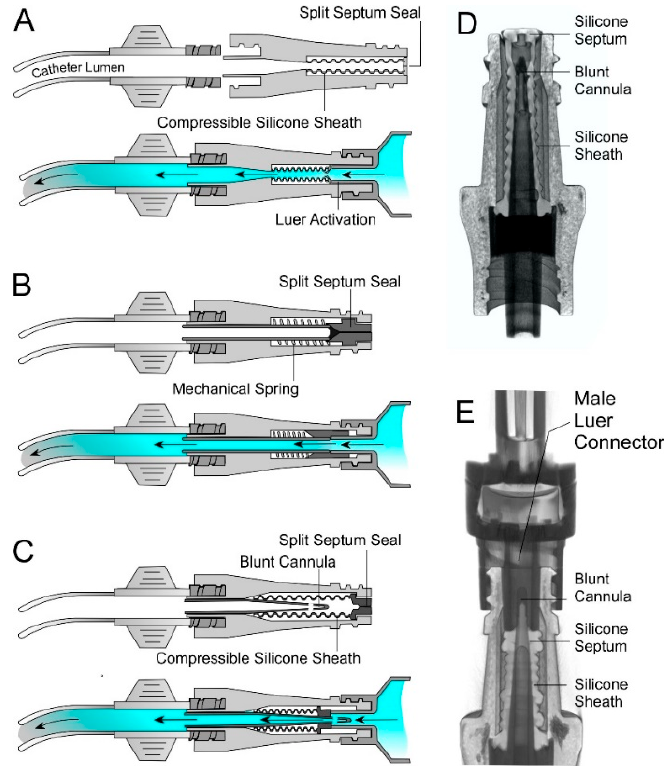
Figure 2. Needle free connectors based on ( A ) simple split septum, ( B ) mechanical spring compression and ( C ) blunt cannula. Computerised tomography scans of the internal components of an intensive care unit (ICU) Medical Clave ™ connector before ( D ) and after connection to a giving set with a Luer connector ( E